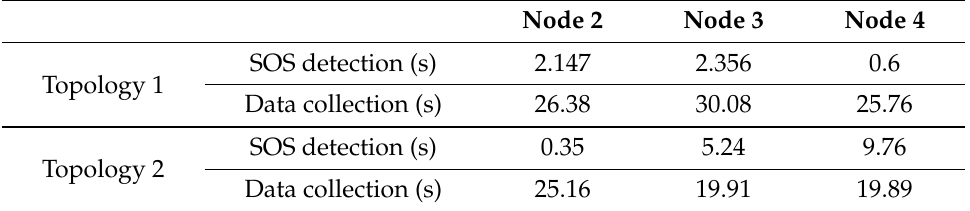
Table 2. Tank test results.